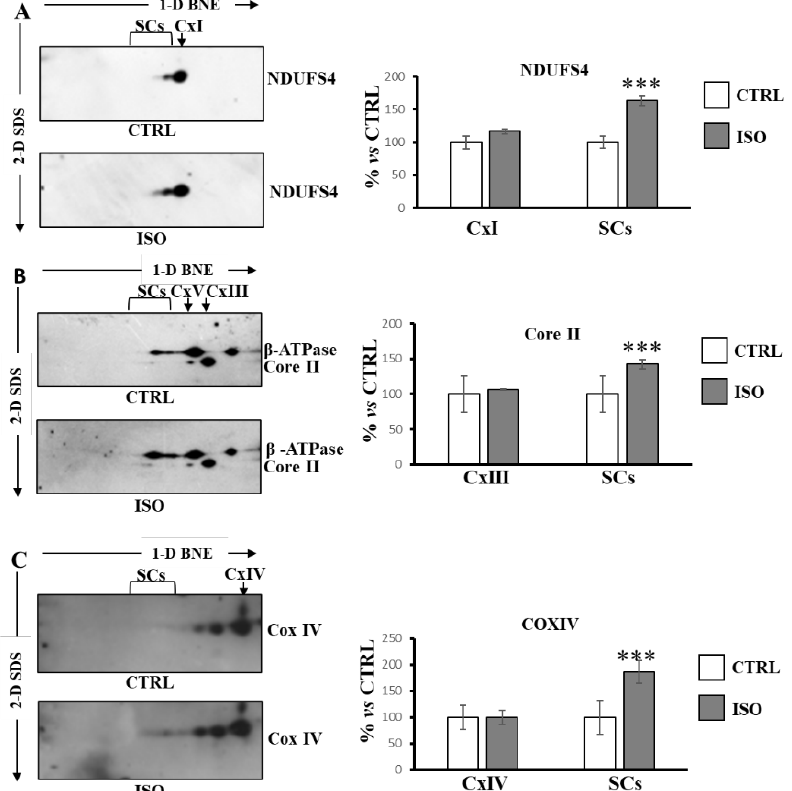
Figure 4. Isoproterenol increased supercomplexes containing complex I, complex III and complex IV. The H9c2 cell cultures were incubated for 30 min in absence (CTRL) or in the presence of isoproterenol (ISO). Mitochondrial solubilized proteins were separated by 1D-BNE/2D-SDS-PAGE and transferred into nitrocellulose membrane, followed by immunoblotting analysis with specific antibodies. ( A ) Representative images of immunoblotting with antibody against NDUFS4. ( B ) Representative images of immunoblotting with antibodies against Core II and β -ATP synthase. ( C ) Representative images of immunoblotting with antibody against Cox IV. ( A – C ) the histograms represent the percentage of ADU of isoproterenol-treated cells (ISO) with respect to untreated cells (CTRL) of immuno-revealed spots in free complexes (CxI, CxIII, CxIV) and in supercomplexes (SCs). The values are the means ± SD of three different experiments. (ISO vs. CTRL, *** p < 0.001, Student’s t -test). For more details, see under Materials and Methods.